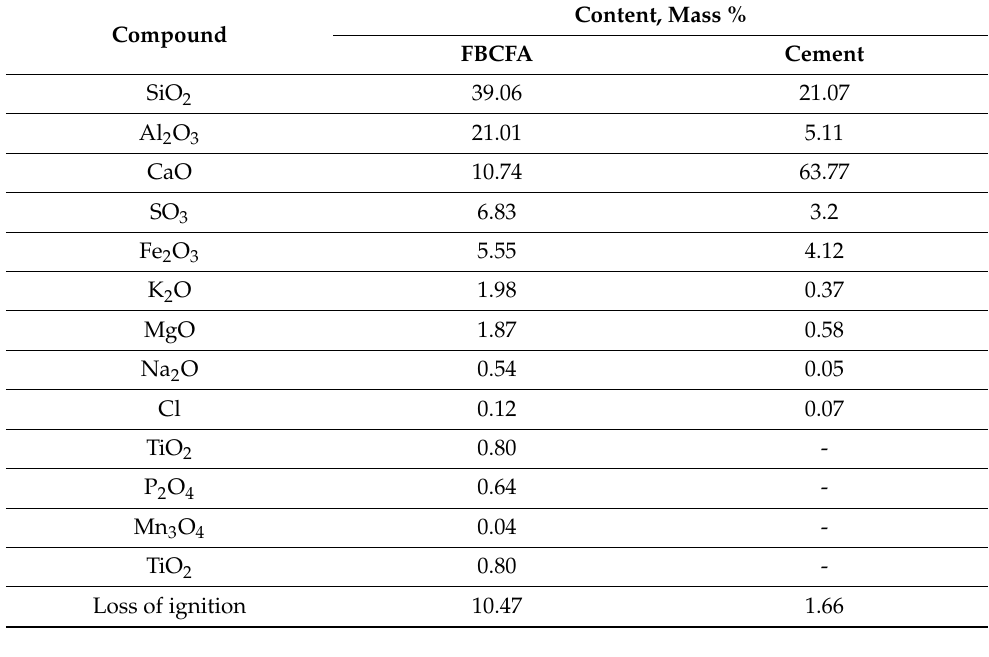
Table 2. Chemical composition of fly ashes and cement.